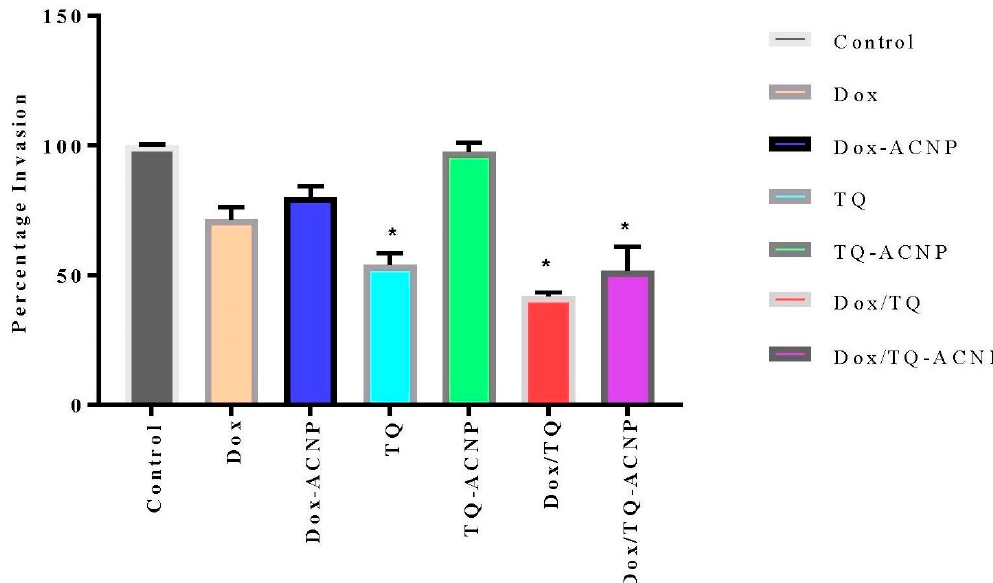
Figure 17. Graphical representation of the percentage of 3D mammosphere cell invasion across the basement membrane compared to control. * p < 0.05 compared to